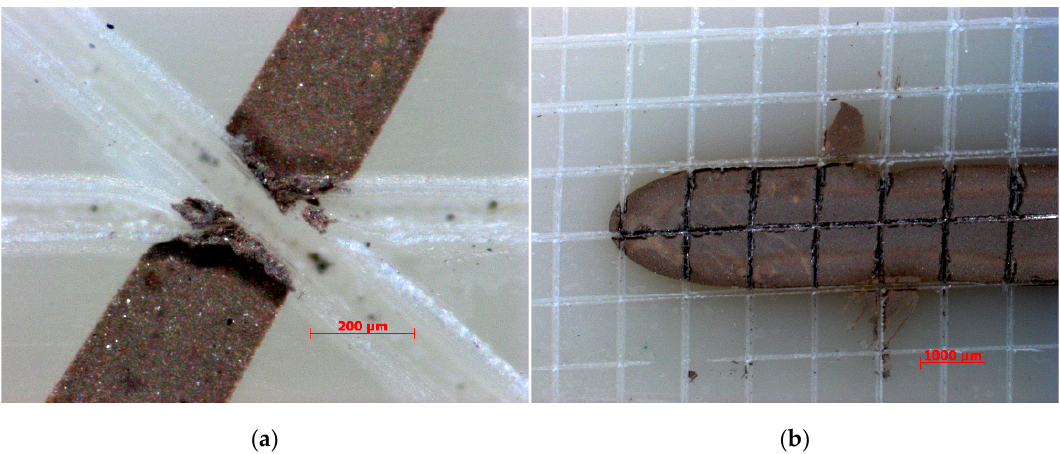
Figure 10. Optical images of the embedded traces after the peeling test for a trace with a nominal width of ( a ) 250 μ m and ( b ) 2000 μ m.